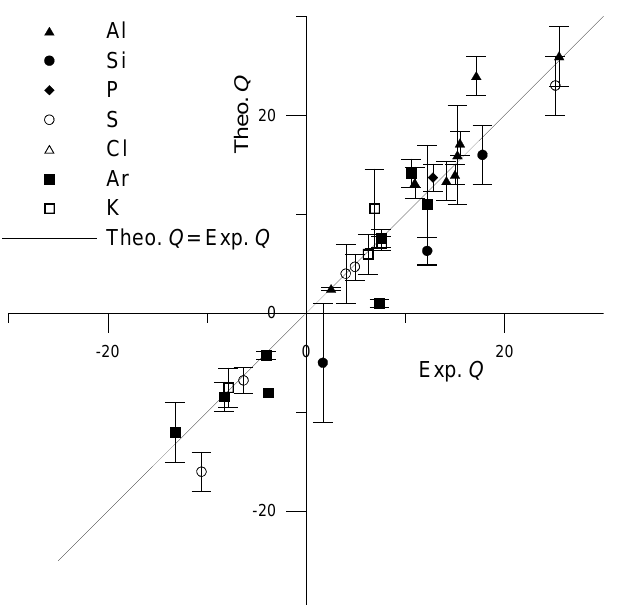
Fig. 8: Comparison of measured and calculated quadrupole moments. The line represents Q =Q theo exp